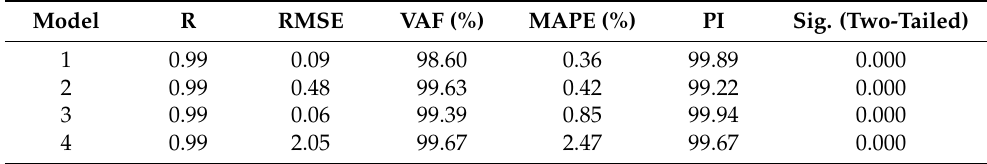
Table 10. Statistical parameters for performance of ANN